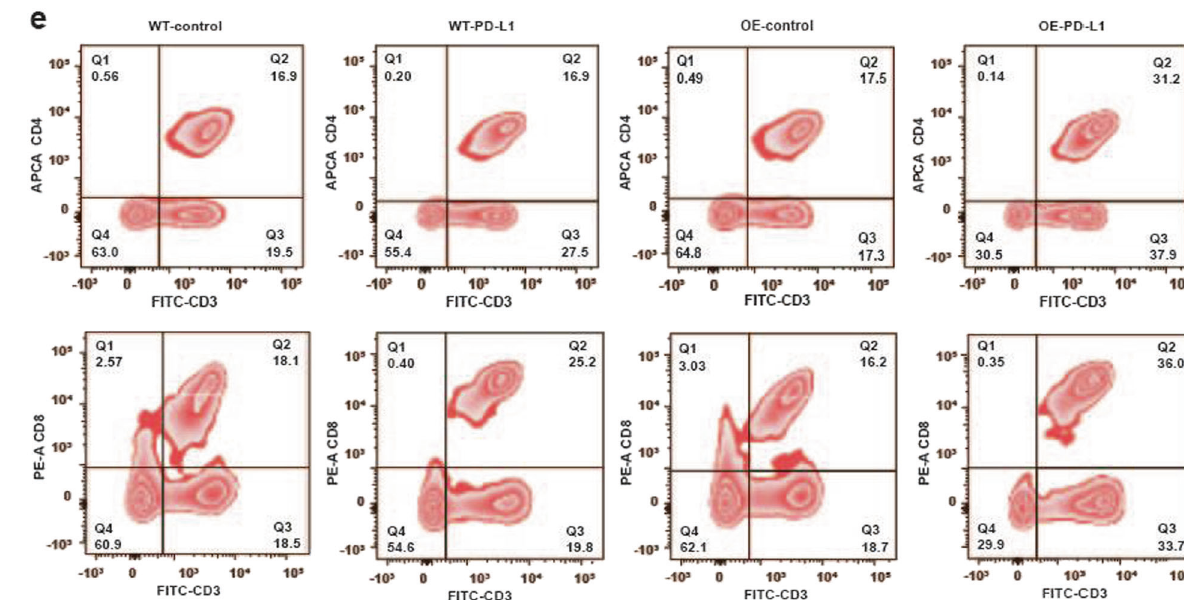
Fig. 7 e Flow cytometry assessing the proportion of CD4/8 + cells with fl uorescent antibodies against the cell markers indicated.